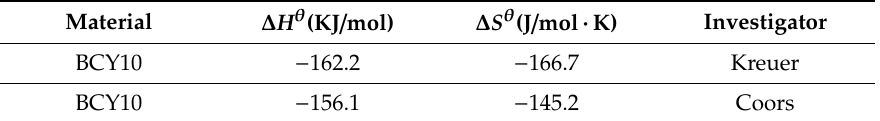
Table 1. Hydration enthalpy and entropy at a constant steam partial pressure of 0.025